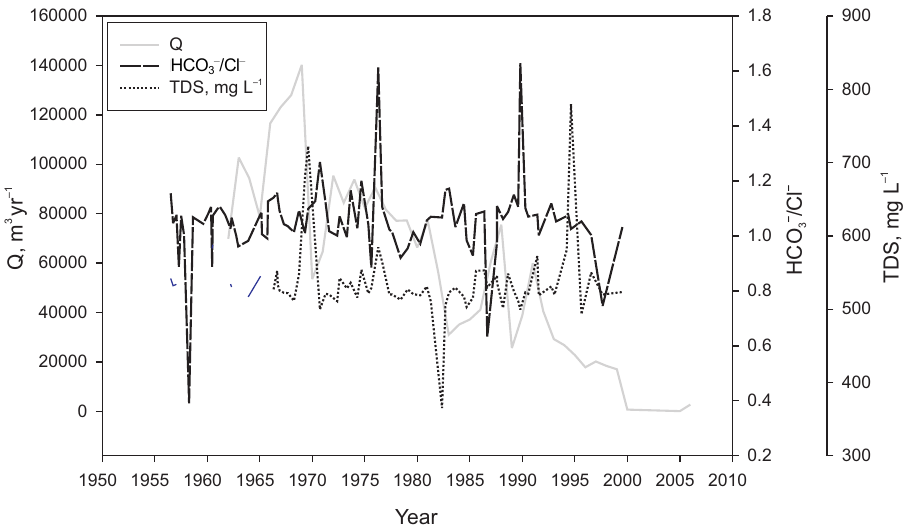
Fig. 6. Fluctuation of the HCO 3 (cid:150) /Cl (cid:150) value in groundwater pumped from well 2470.